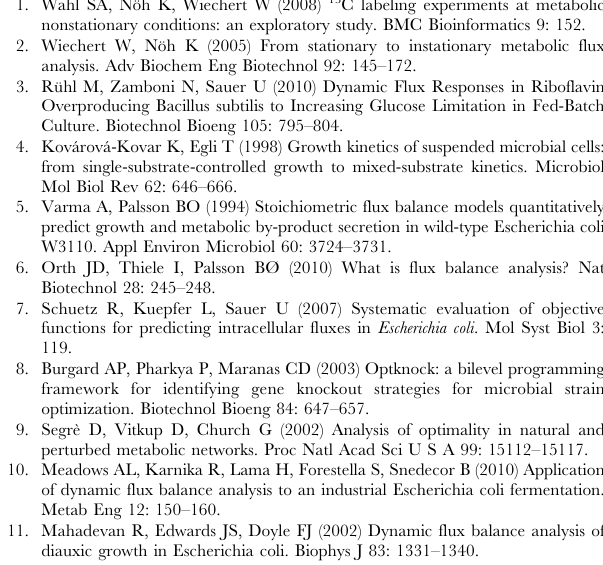
Figure S1 Experimental observed and simulated isotopomer labeling patterns [M-57] + in key proteinogenic amino acids. The standard error for GC-MS measurement was , 0.02. Area plot: dynamic isotopomer simulation (case 1: simulation without considering reaction reversibility; case 2: simulation considering reaction reversibility). Bar plot: comparison of experimental data